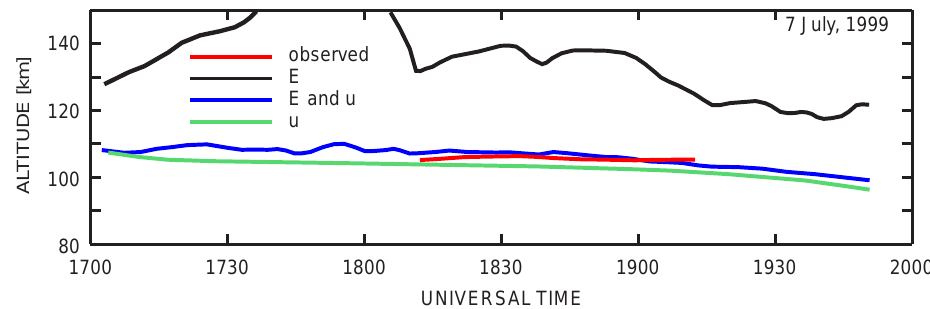
Fig. 4. Same as Fig. 2 for 7 July